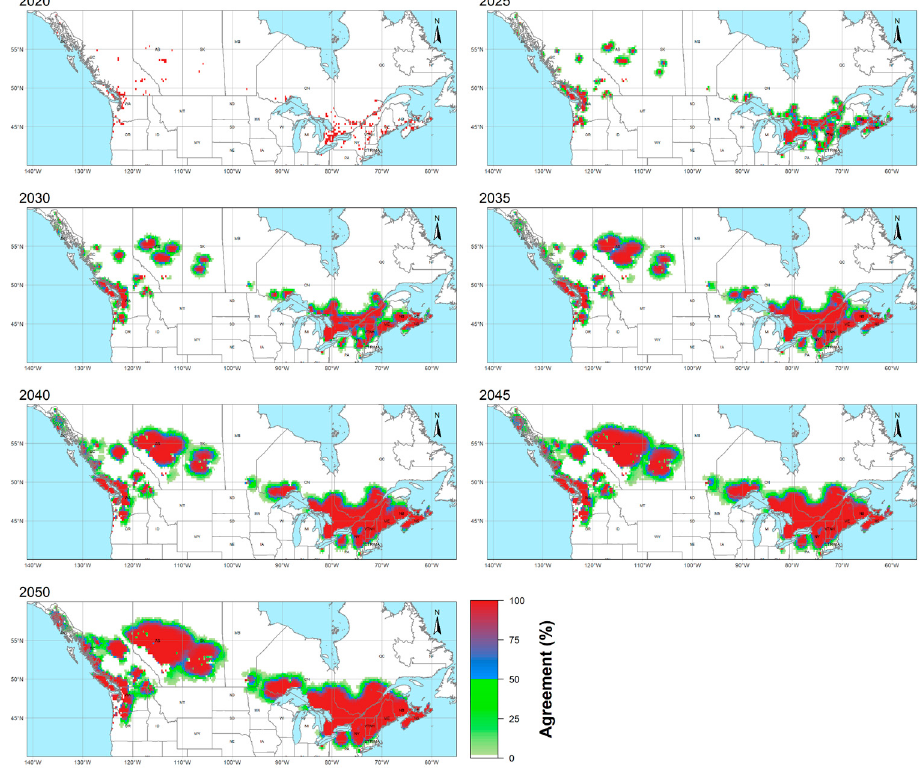
Figure 4. 5-year inter-simulation agreement maps for the projected invasive range of I. glandulifera in North America.